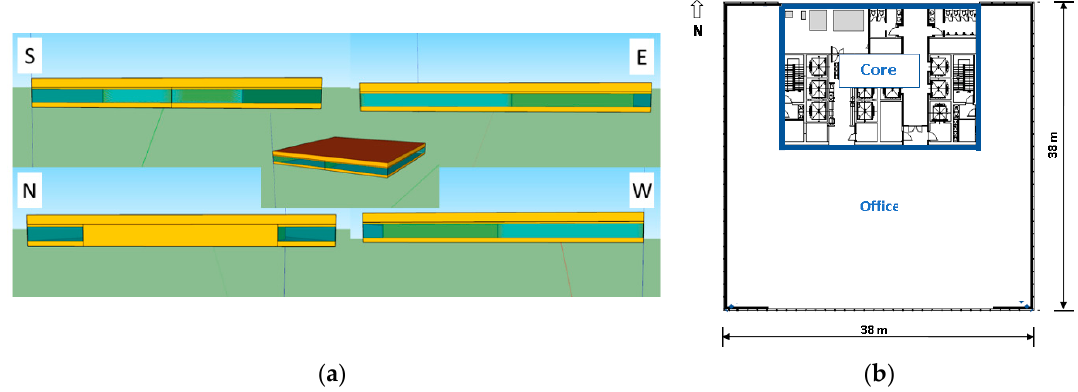
Figure 6. Modeling of standard office building (middle floor only): ( a ) 3D model; ( b ) floor plane.